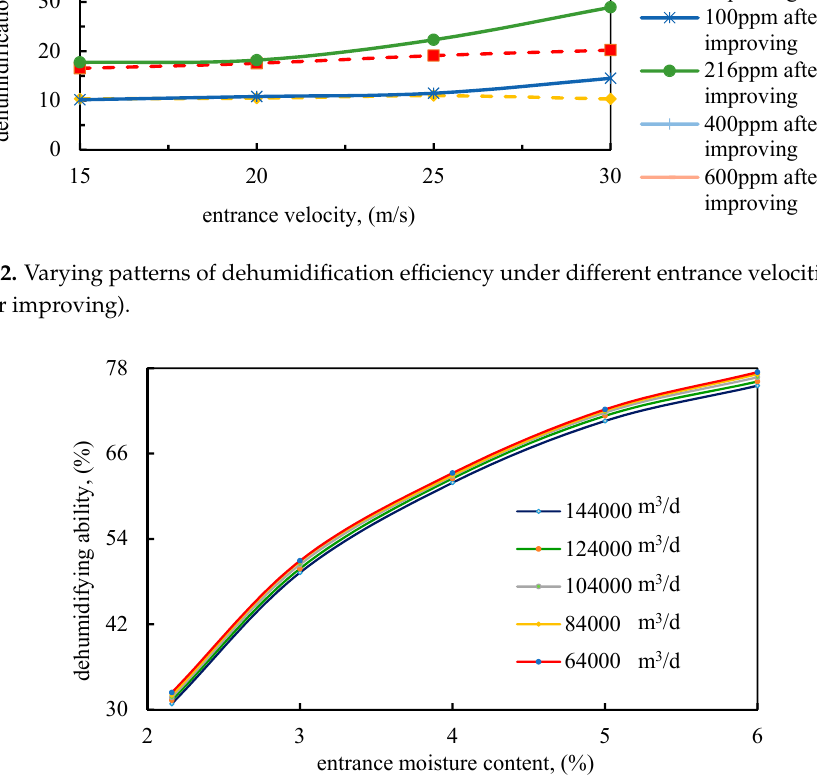
Figure 13. The separation efficiency with different scene influence factors.